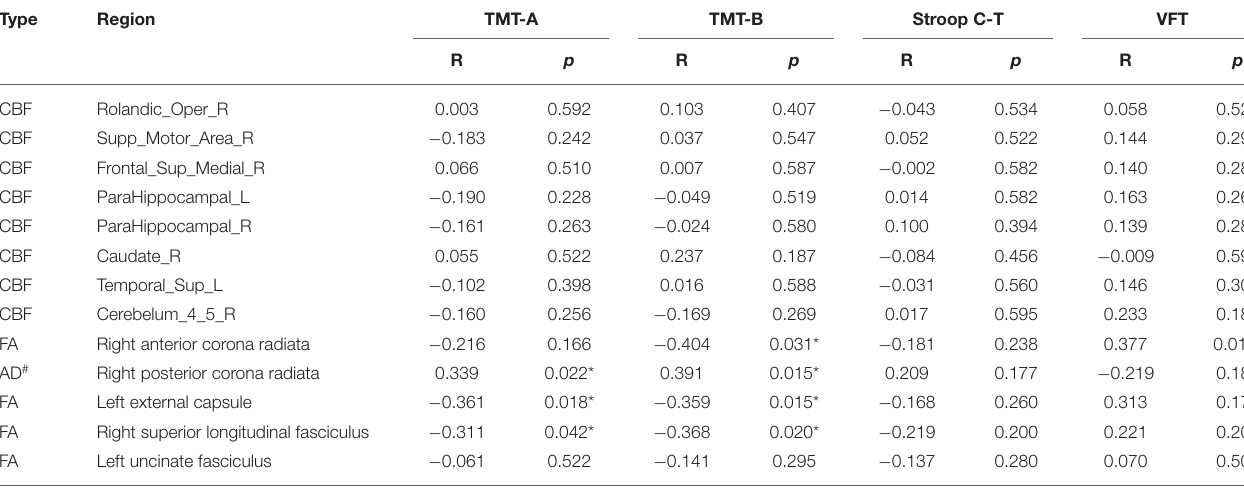
TABLE 4 | Correlations between discriminative combined diffusion/perfusion features and executive function tests in vMCI group.